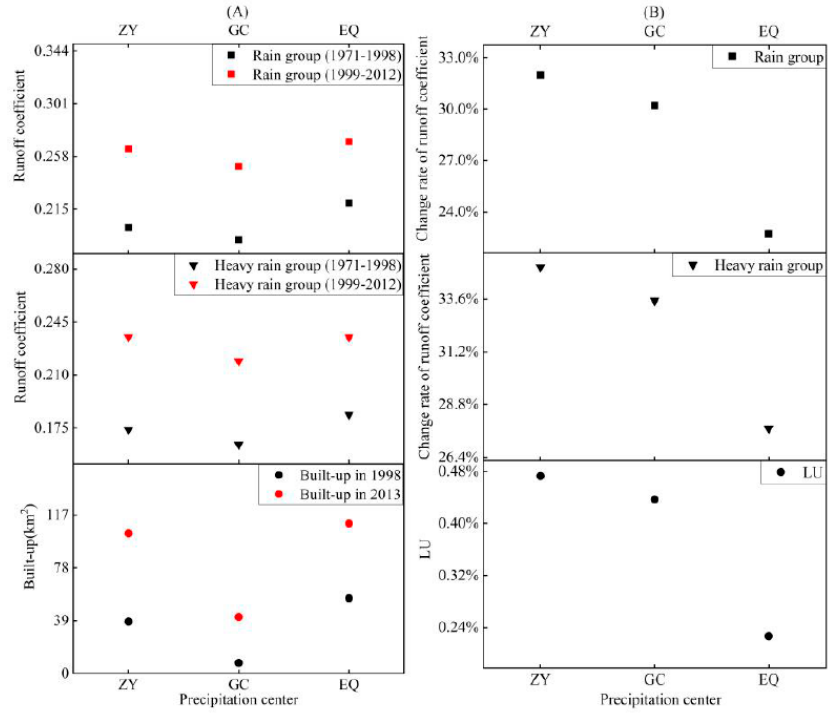
Figure 9. ( A ) Relationship between built-up and runoff coefficient, ( B ) relationship between LU and change of runoff coefficient.